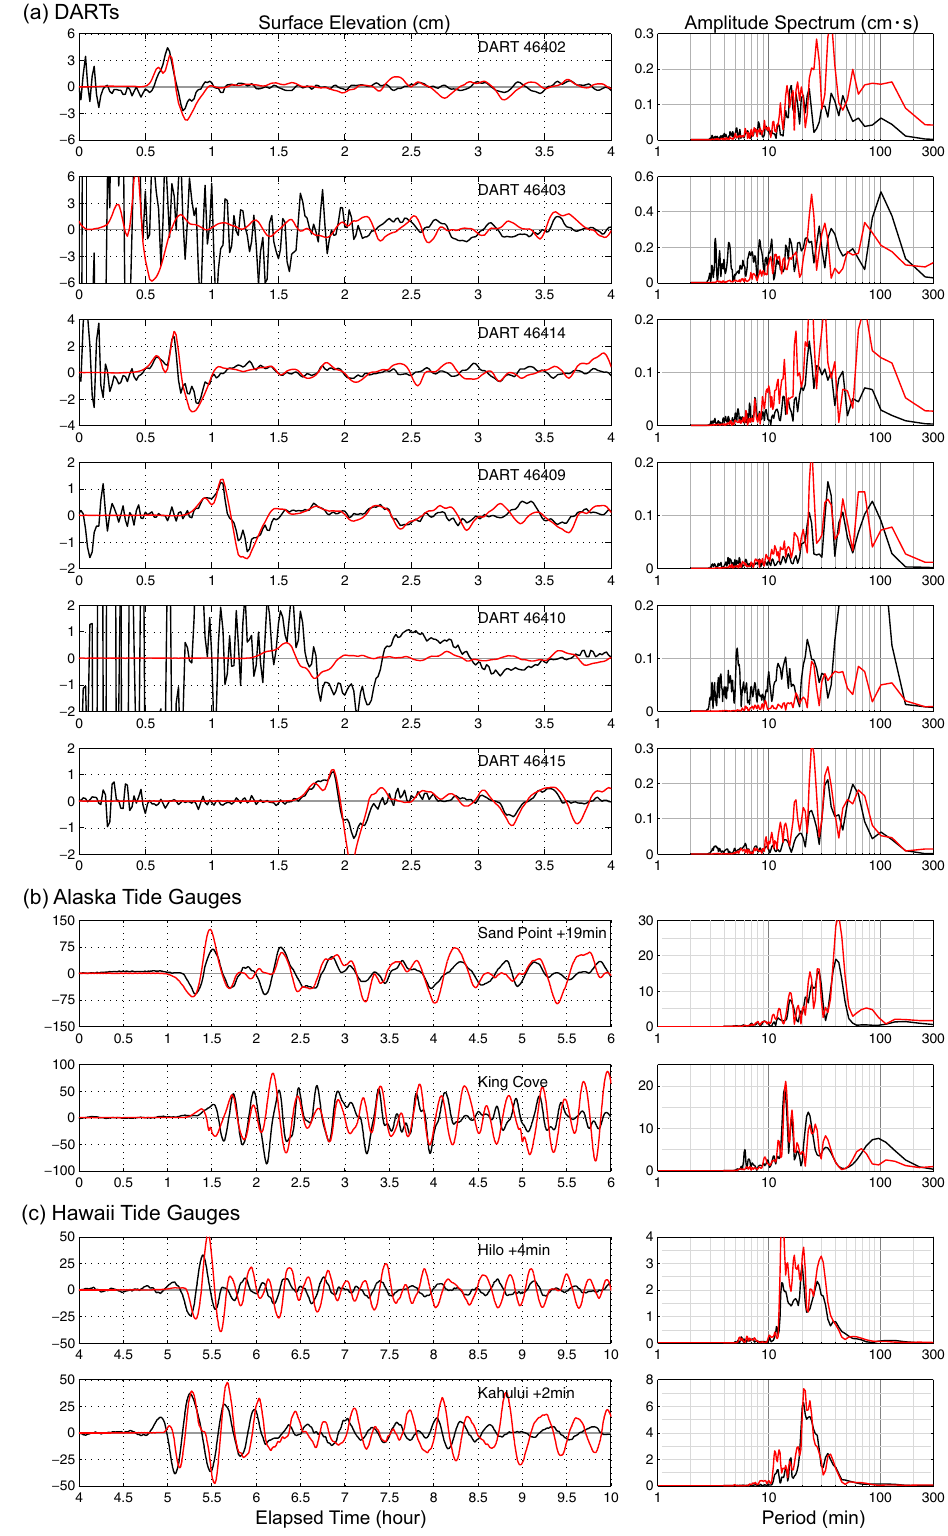
Fig. 6 | Tsunami predictions for a two-fault plus dipole model. Observed (black lines) and predicted (red lines) tsunami surface elevation time series (left column) andspectra(rightcolumn)forthe2-faultmodelplusdipolemodelinFig.5. a DART